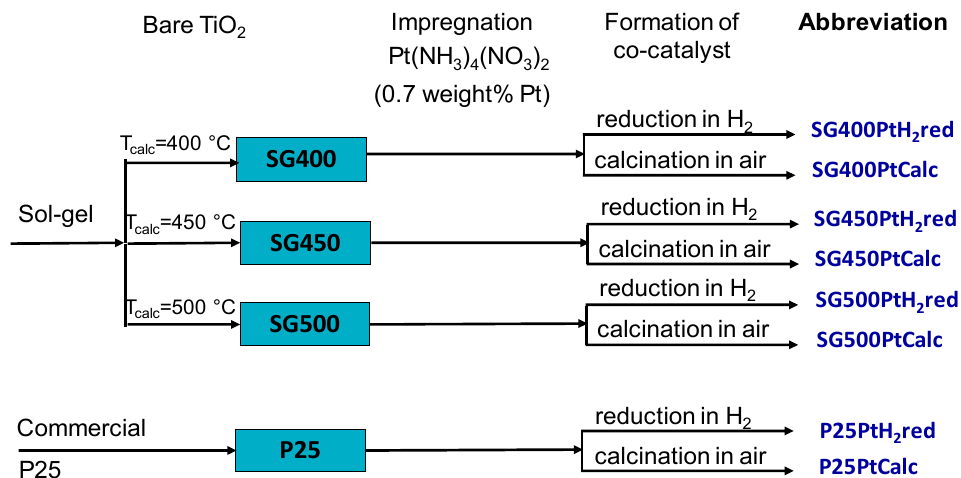
Figure 1. Denomination of the various Pt-PtO x /TiO 2 catalysts.